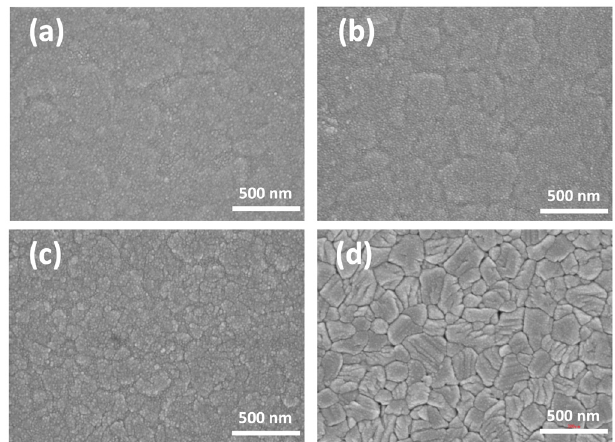
Figure 2. The surface morphology of V 2 O 5 thin film after thermal annealing at various temperatures with a magnification of 50,000× ( a ) without annealing ( b ) 200 °C, ( c ) 300 °C, and ( d ) 400 °C, respec- tively.